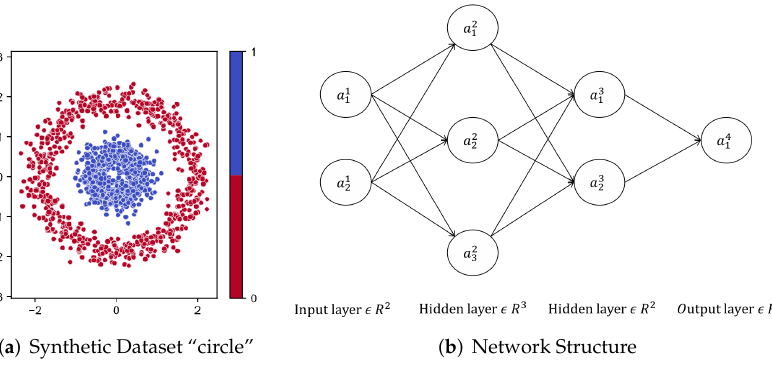
Figure 1. ( a ) “Concentric Circle” dataset and ( b ) network